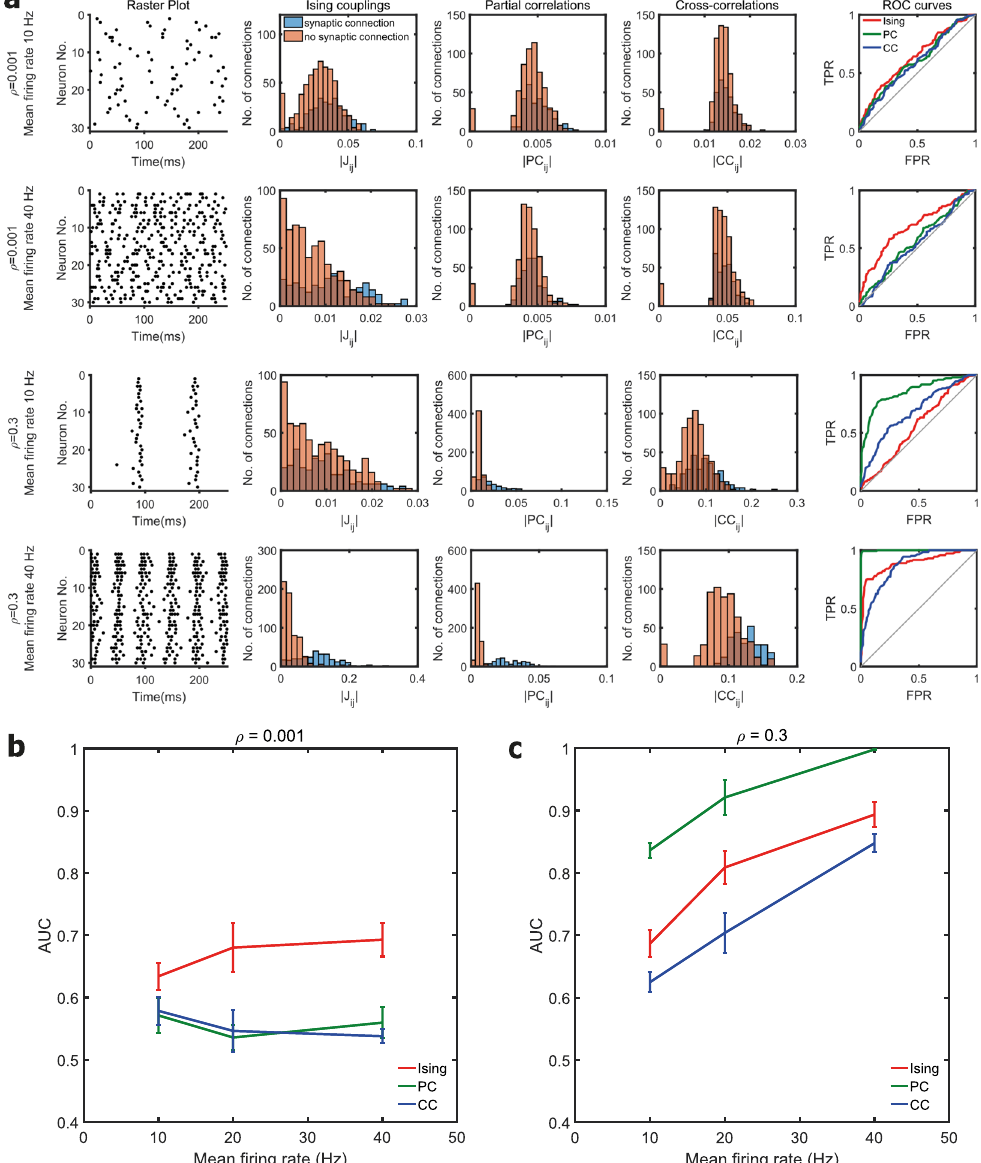
Figure 2. Effect of mean network firing rate. ( a) The first and second rows correspond to firing rates of 10 Hz and 40 Hz respectively for a fixed correlation level ( ρ ) of 0.001. The third and fourth rows correspond to firing rates of 10 Hz and 40 Hz respectively for a fixed correlation level of 0.3. Raster plot of the spiking activity from a simulated neuronal network is shown in the first column. Histogram of the Ising couplings, partial correlations and cross-correlations for the pairs of neurons that are synaptically connected and not connected are shown respectively in the second, third and fourth columns. The corresponding ROC curves of the three functional connectivity metrics are shown in the last column. (b) and (c) Plot of the AUC values for different firing rates in scale-free networks of 30 neurons for fixed mean network correlation levels of 0.001 and 0.3 respectively. Mean value was calculated from ten simulated